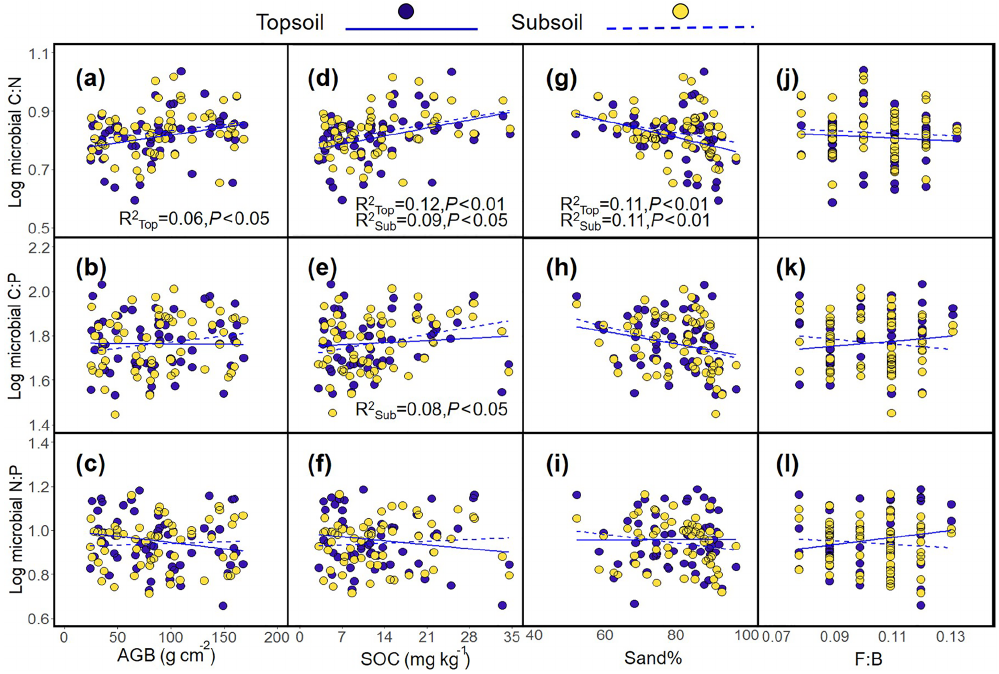
Figure 3. Relationships between the C:N, C:P, and N:P ratios in the soil microbial biomass and AGB (a–c) , SOC (d–f) , sand percentage (g– i) , and F:B ratio (j–l) . AGB, aboveground biomass; SOC, soil organic carbon; F:B ratio, fungi-to-bacteria